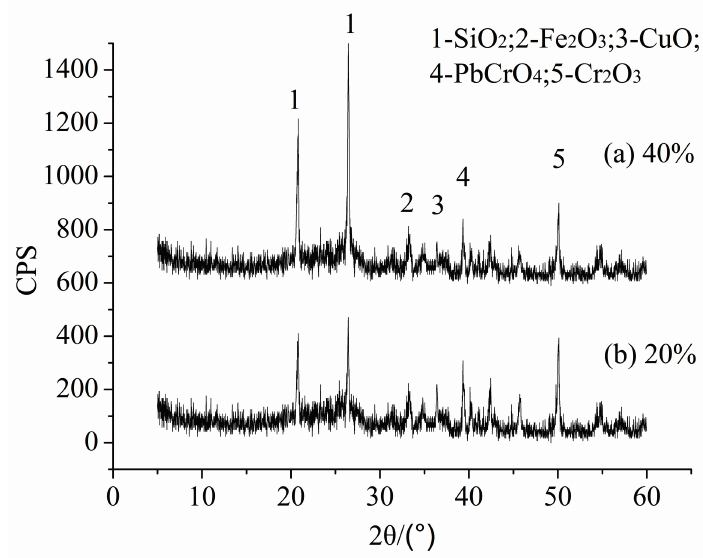
Figure 3. XRD analyses of LWA containing sludge with different MSWI fly ash contents: ( a ) 20%; ( b )